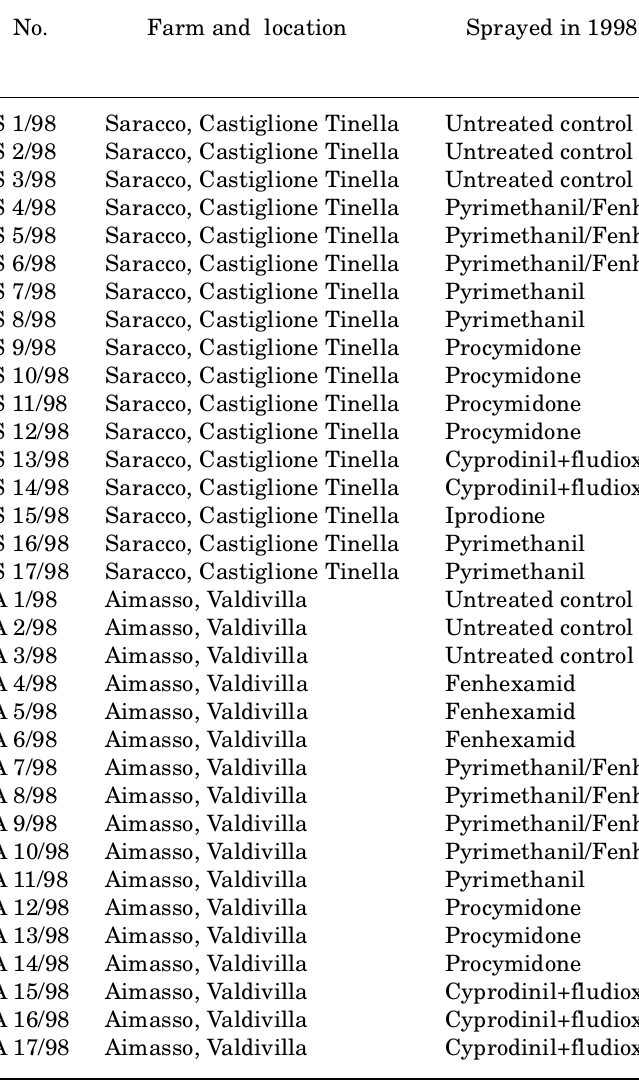
% of conidia resistant